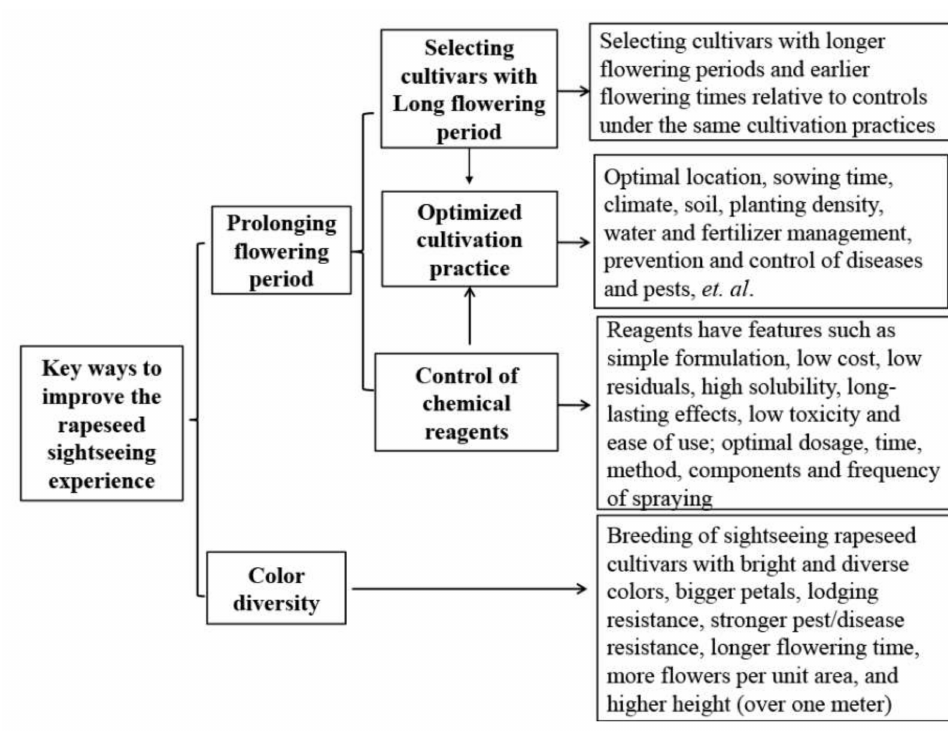
Figure 8. Key points for rapeseed as a tourist